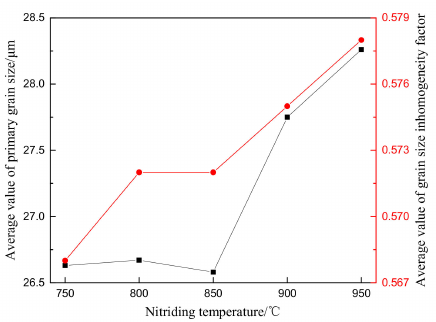
Figure 2. Relation between nitriding temperature and average values of primary grain size and its inhomogeneity factor in a nitrided sheet.